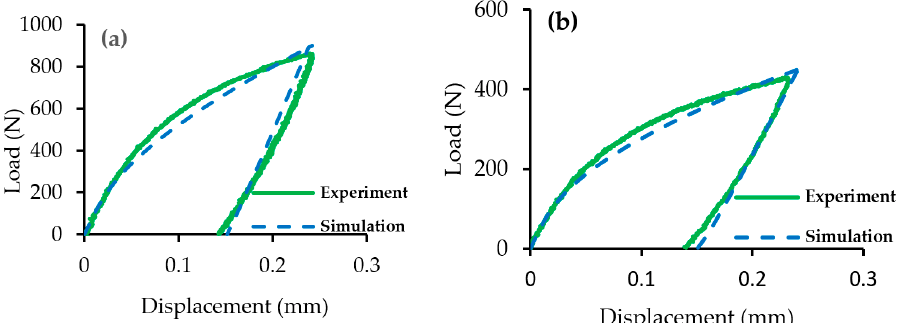
Figure 4. Comparison of experimental and simulation results of ( a ) bulk plate (0% of porosity) and ( b ) the plate with the porosity of 30% .